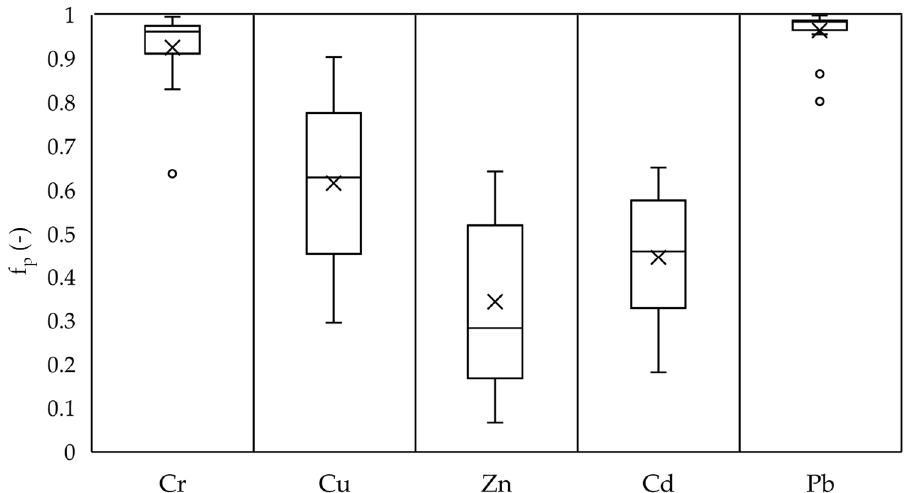
Figure 7. Distribution of the particulate fraction, f p , for chromium (Cr), copper (Cu), zinc (Zn), cadmium (Cd), and lead (Pb) on event basis (n = 17).